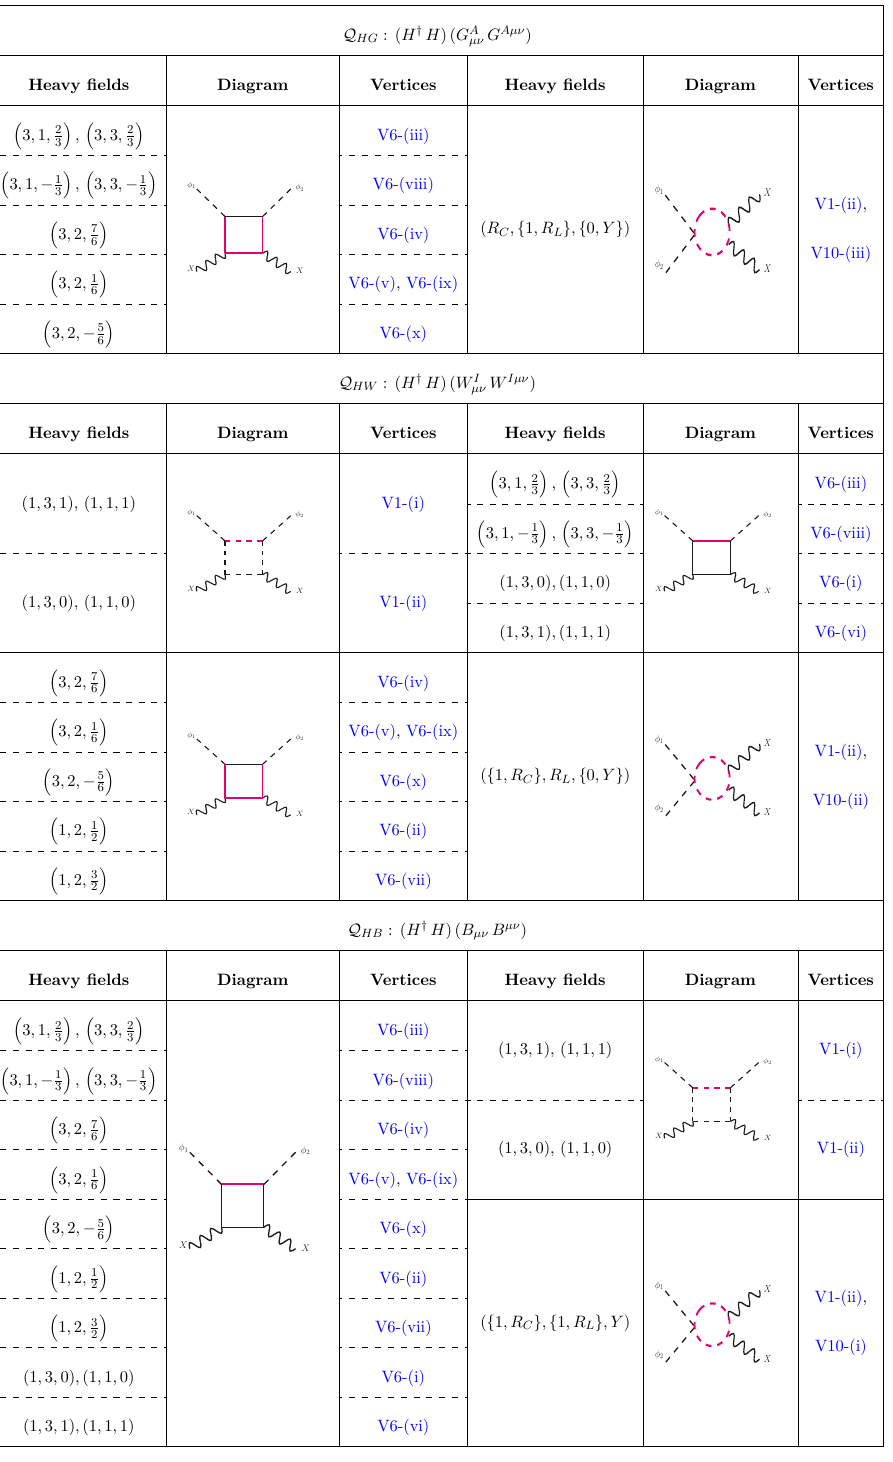
Table 10 . Heavy field representations that are obtained by unfolding the φ 2 X 2 operators into non-trivial one-loop-level diagrams and the corresponding